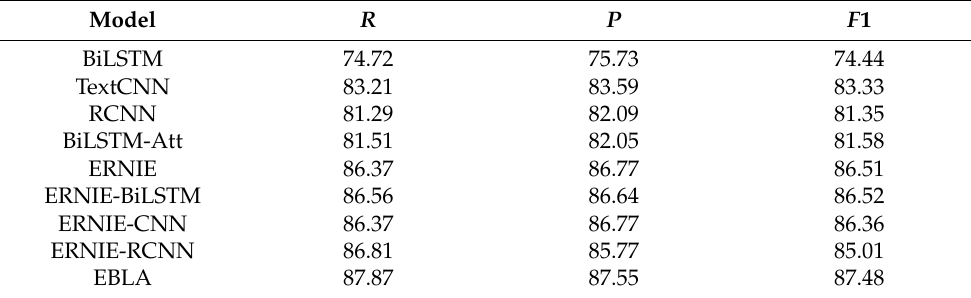
Table 5. Performance comparison of different sentiment analysis models